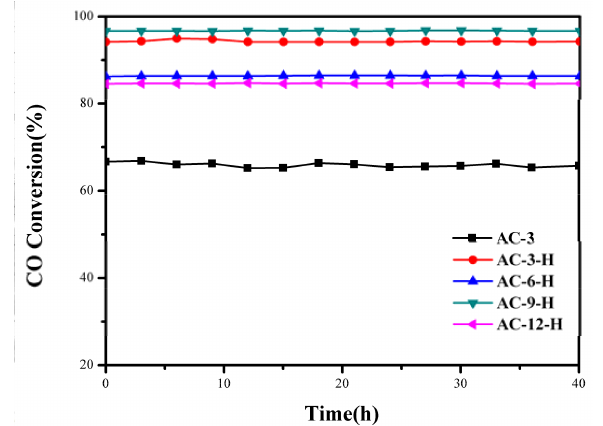
Figure 2. Stability tests of the Au-CeO 2 with the different calcination times (3 h, 6 h, 9 h and 12 h) pretreated in H 2 atmospheres at 100 ◦ C for CO oxidation.